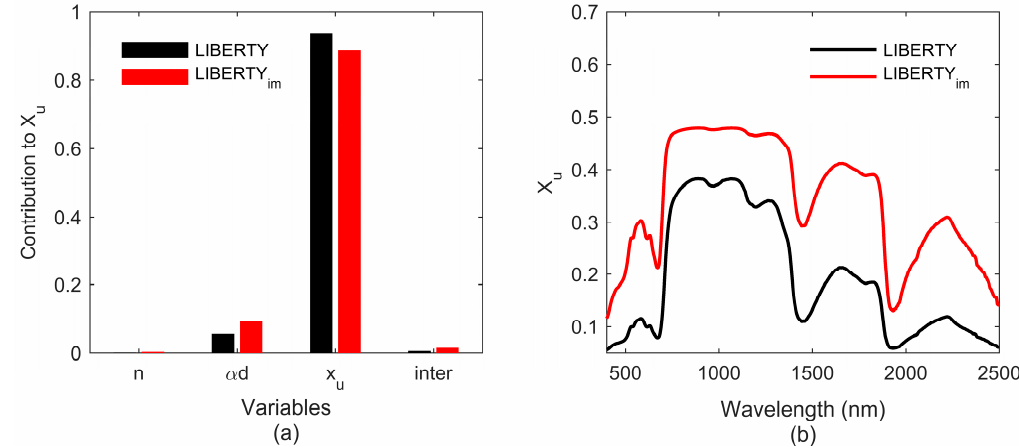
Figure 11. Comparisons of the sublayer backscattering ratio X u between LIBERTY and LIBERTY im . ( a ) results of Fourier amplitude sensitivity test (FAST) first-order sensitivity coefficients to the sublayer backscattering ratio. n is the relative refractive index, α d is the diametrical absorbance, x u is the particle backscattering ratio, inter denotes the interactions. Input parameters for models are listed in Table 4. Their ranges were taken from Table 1; ( b ) calculated sublayer backscattering ratio X u for LIBERTY and LIBERTY im with the same input parameters. The particle diameter d , the particle backscattering ratio x u , the number of sublayers N , baseline, the albino absorption, chlorophyll content (% dry matter), water content (% dry matter), lignin and cellulose content (% dry matter) and protein content (% dry matter) were set to 40 µ m, 0.045, 1.6, 0.0005 µ m − 1 , 2 mg · g − 1 , 200 mg · g − 1 , 100 mg · g − 1 , 40 mg · g − 1 and 1 mg · g − 1 , respectively.